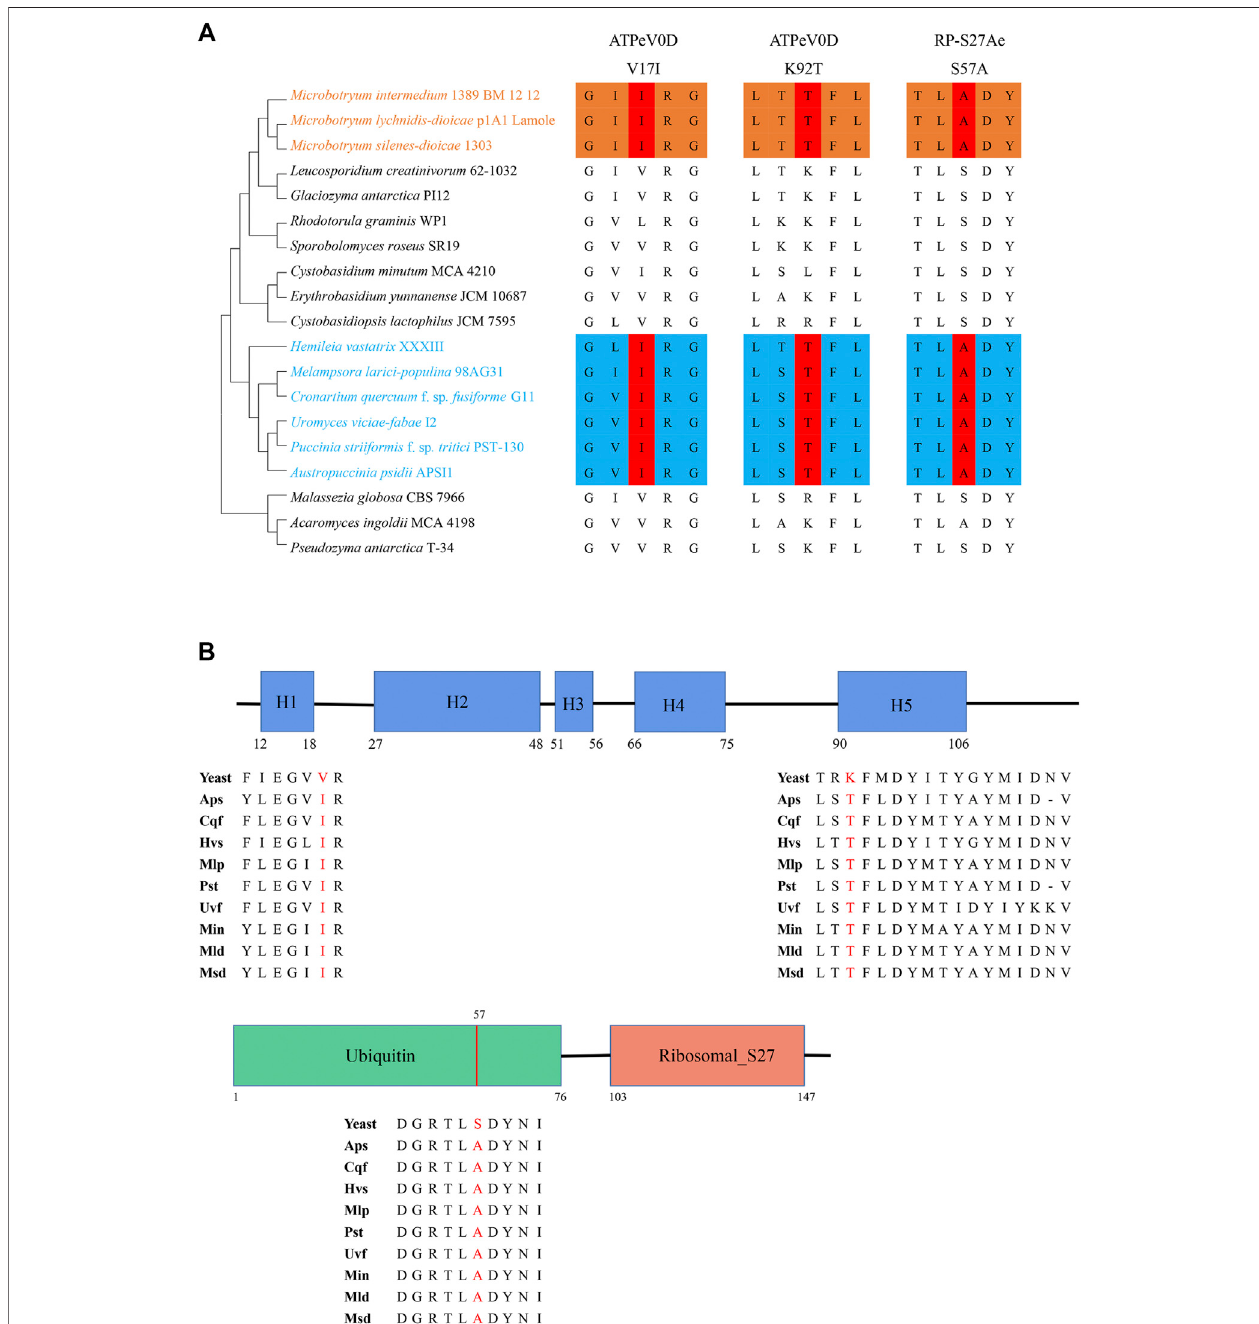
FIGURE 3 | Two convergent genes. (A) Convergent amino acid substitutions in ATPeV0D and RP-S27Ae among the 19 fungi. The number above the convergent sitedenotestheaminoacidposition. (B) StructuraldomainsofATPeV0DandRP-S27Aeandthelocationsofthreeconvergentaminoacidsites.Thestructuraldomainof ATPeV0D was annotated based on the VMA6 protein in Saccharomyces cerevisiae , and that of RP-S27Ae was annotated based on the RPS31 protein in S. cerevisiae .